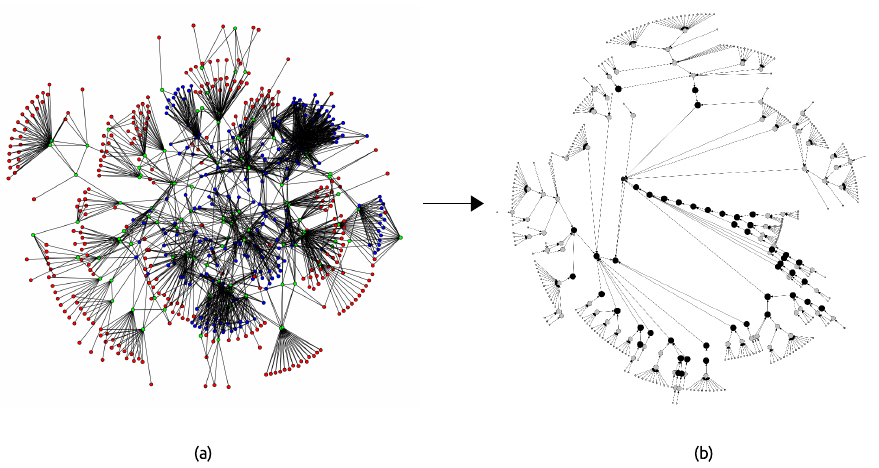
Figure 12. Real network topology conversion for NDNtube: ( a ) Raw AT&T network topology, ( b ) rocket-fuel-converted AT&T for ndnSIM.